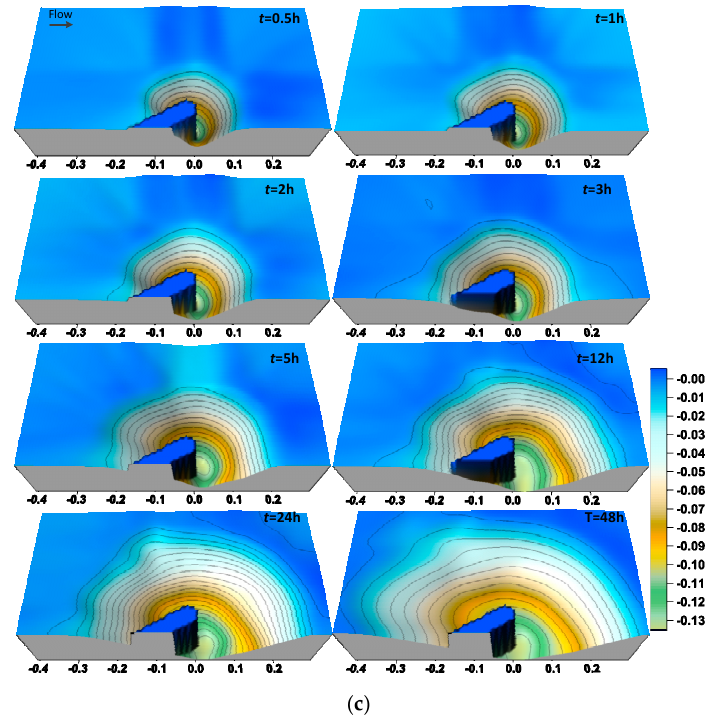
Figure 2. 3-D structure of scour holes (axis unit: m); ( a ) θ = 150° ( b ) θ = 90° ( c ) θ = 30°.